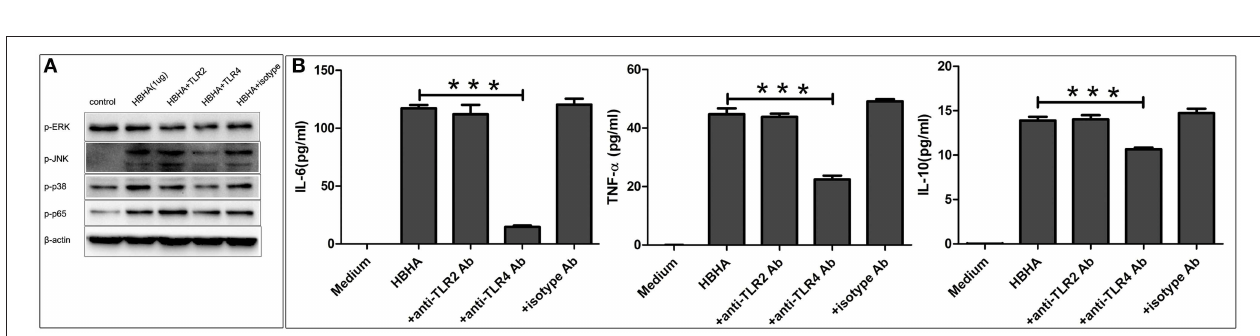
FIGURE 7 | HBHA-mediated cytokine secretion is dependent on mitogen-activated protein kinase (MAPK) and nuclear factor kappa B (NF- κ B) signaling pathways at both the protein and mRNA levels. (A) RAW264.7 cells were pretreated with PD98059 ( + PD; 20 µ M), SB203580 ( + SB; 10 µ M), SP600125 ( + SP; 20 µ M), BAY 11-7082 ( + BAY; 0.5, 1, and 2 µ M), or DMSO (0.01%) and then induced with HBHA (1 µ g/ml). IL-6, TNF-a, and IL-10 in supernatants were measured by ELISA after incubation for 18h. (B) RAW264.7 cells were pretreated with PD98059 ( + PD; 20 µ M), SB203580 ( + SB; 10 µ M), SP600125 ( + SP; 20 µ M), or BAY 11-7082 ( + BAY; 2 µ M) and were then induced with HBHA (1 µ g/ml) for 6h. The relative mRNA levels of IL-6, TNF- α , and IL-10 were calculated and expressed as the fold changes relative to that of the control. Data are expressed as the mean ± SD from three separate experiments. *** P < 0.001.